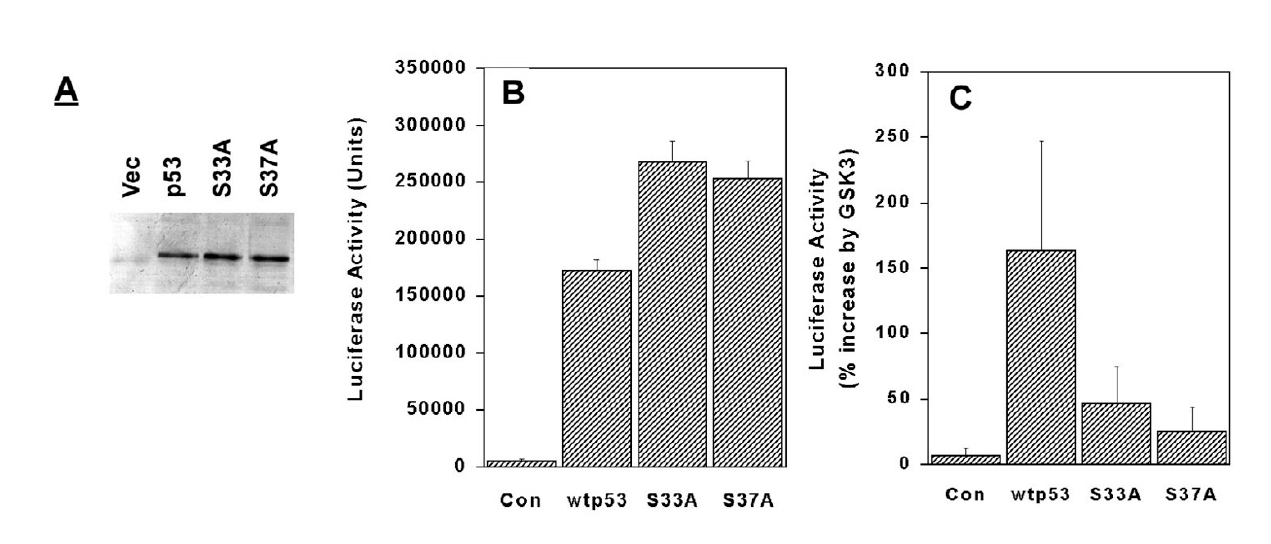
Figure 3 GSK3 β regulates p53 transcriptional activity. (A) SAOS-2 cells were transiently transfected with vector (pcDNA3.1), or expression vectors for wtp53, wtp53S33A (S33A) or wtp53S37A (S37A). p53 expression was detected by western blotting. (B+C). SAOS-2 cells were transiently transfected with p50-2, a p53-responsive luciferase reporter construct, and 50 ng